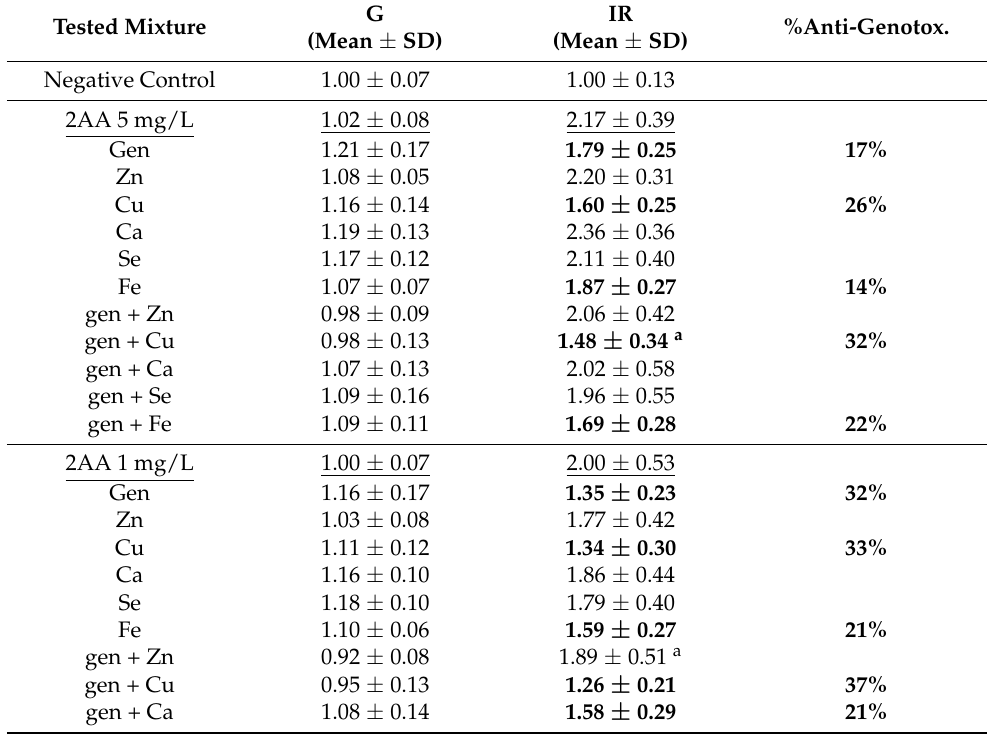
Table 5. Evaluation of anti-genotoxic activity based on G and IR values for the genotoxin—2AA (5 mg/L, 1 mg/L)—and the mixture of 2AA with genistein, minerals and combinations. G IR Tested Mixture (Mean ± SD) (Mean ± SD)